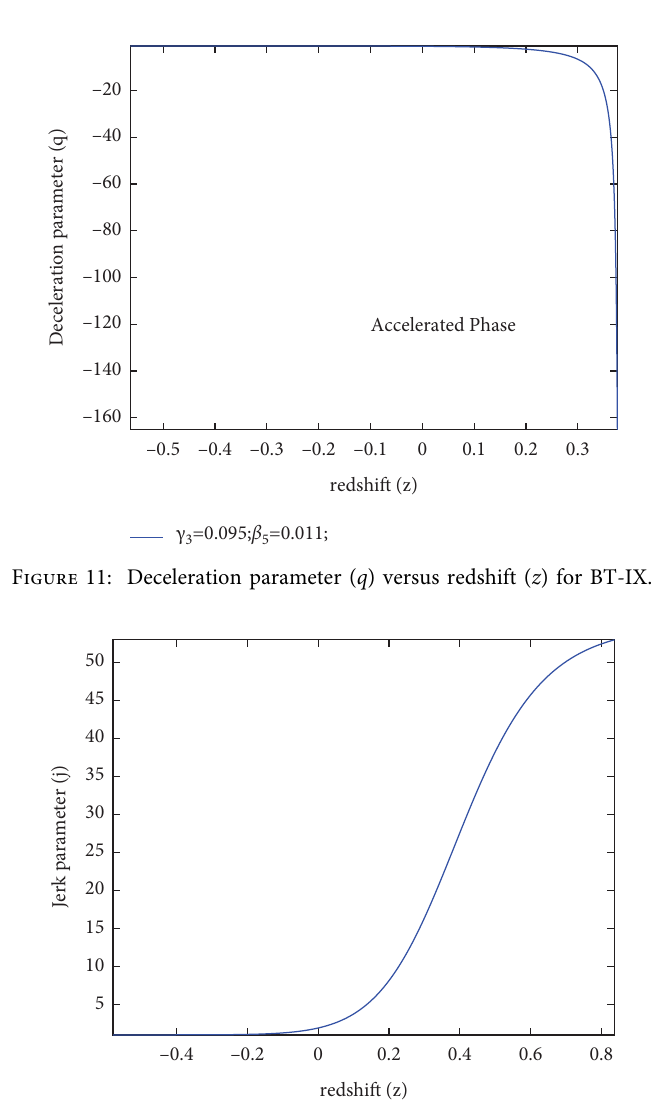
Figure 10: Deceleration parameter ( q ) versus redshift ( z ) for BT-VIII.